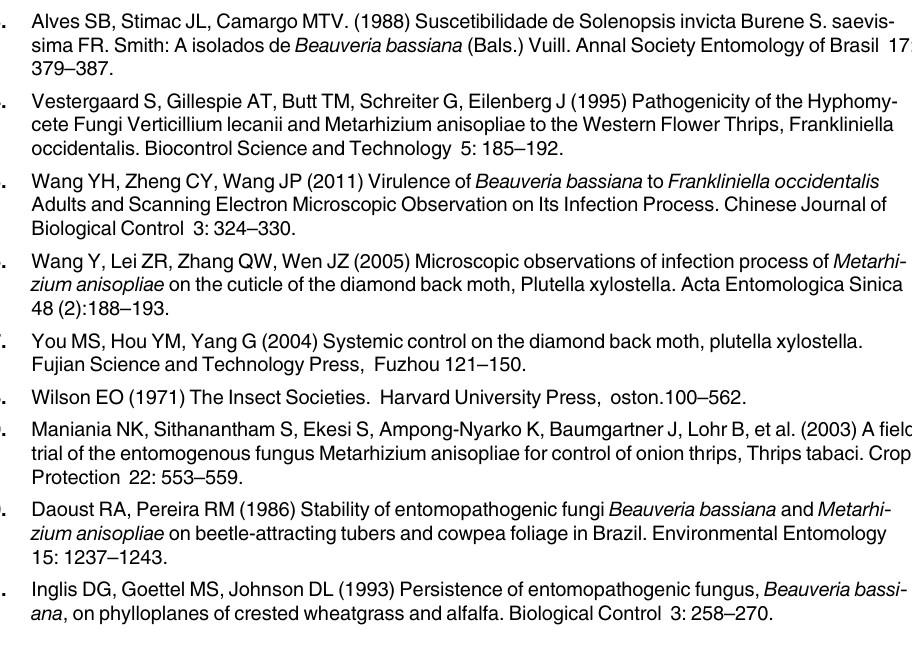
PLOS ONE | DOI:10.1371/journal.pone.0158325 June 24,